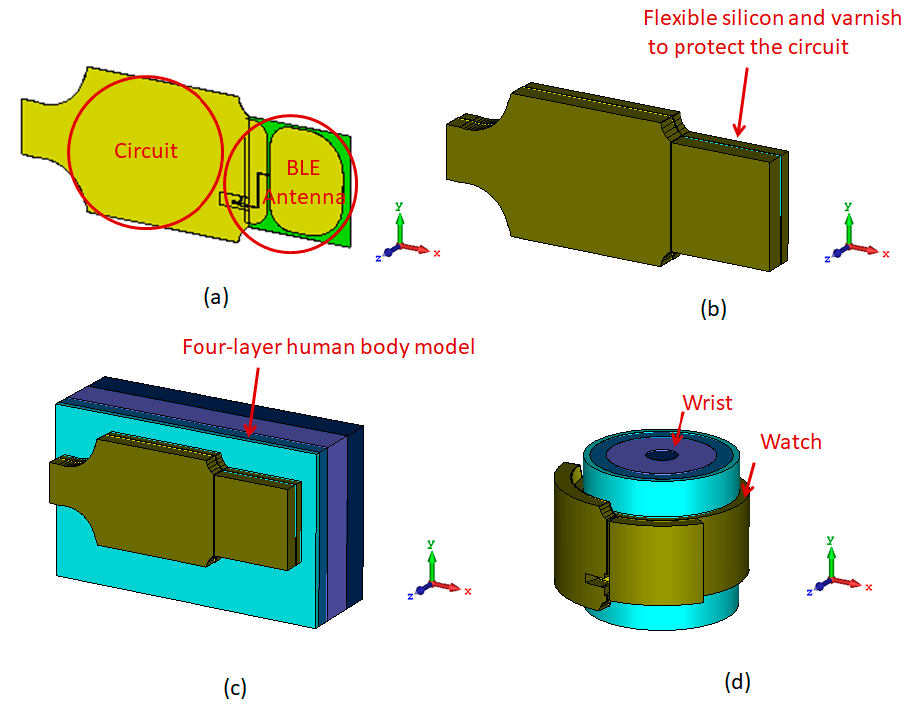
Figure 3. Configuration of antenna: ( a ) Integrated with the circuit (A1); ( b ) Protected by two layer of varnish and flexible silicon (A2); ( c ) Placed next to the human body (A3); ( d ) Bent around the human’s wrist (A4) .